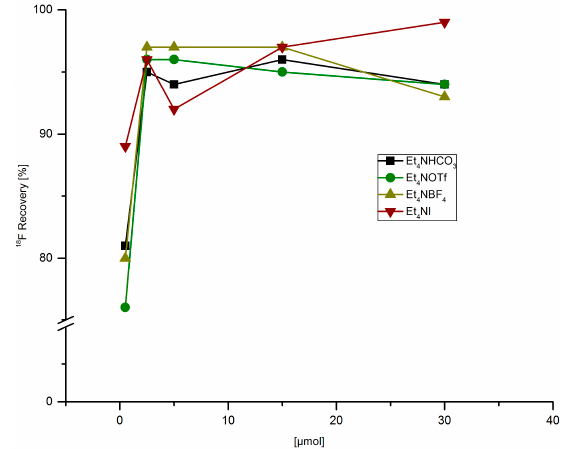
Figure 1. 18 F-Recovery from anion exchange resin with MeOH solutions of different tetramethylammonium salts. Conditions: [ 18 F]Fluoride (~50 MBq) was fixed on a QMA-CO 3